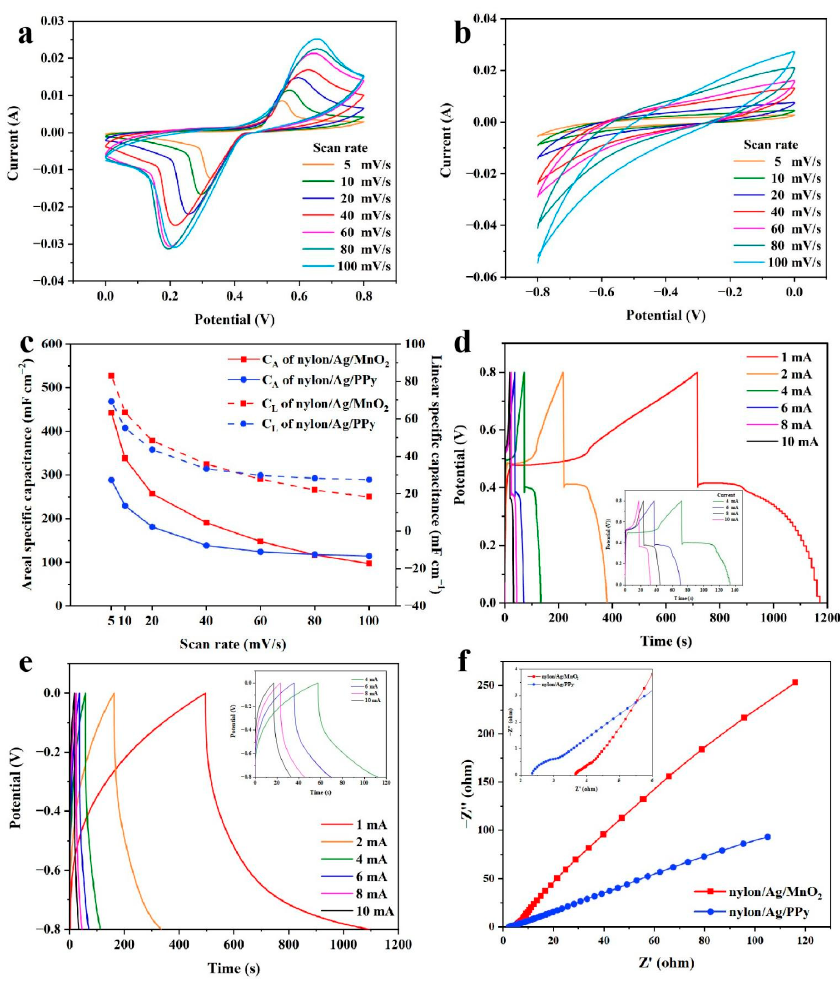
Figure 7. ( a , b ) CV curves of the ( a ) nylon/Ag/MnO 2 and ( b ) nylon/Ag/PPy electrodes at different scan rates; ( c ) the C L and C A calculated from CV curves in ( a , b ) of the two electrodes at different scan rates; ( d , e ) GCD curves of ( d ) nylon/Ag/MnO 2 and ( e ) nylon/Ag/PPy electrodes at different charge/discharge currents (the inset shows the GCD curves from 4 mA to 10 mA); ( f ) EIS of the electrodes (the inset shows the enlarged view of the high-frequency region).